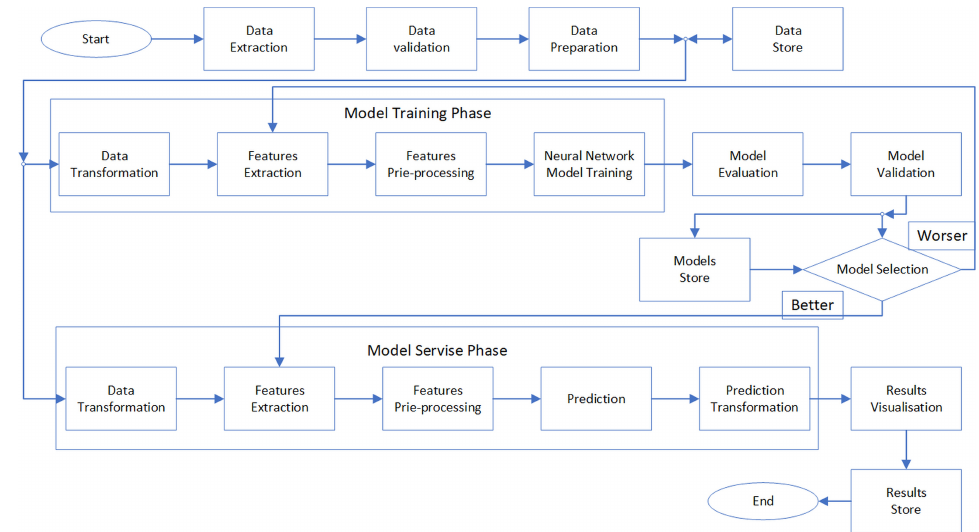
Figure 2. Proposed data analysis